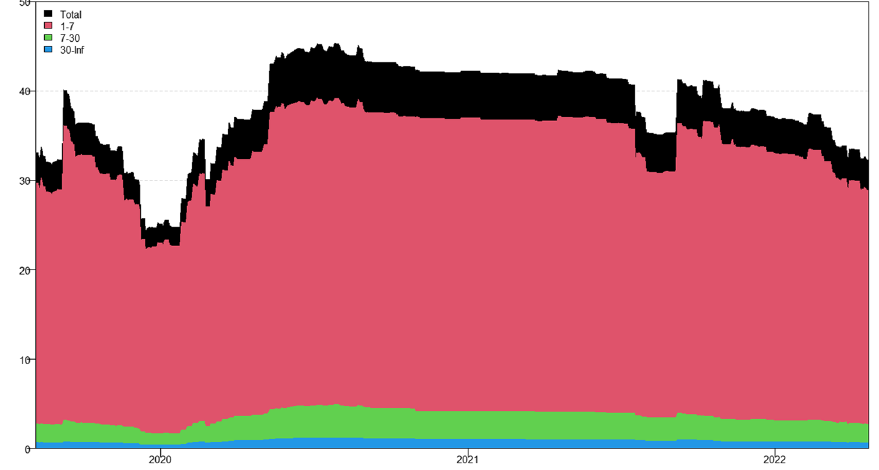
Fig. 24 Dynamic total connectedness—realized hyperskewness (RHS)